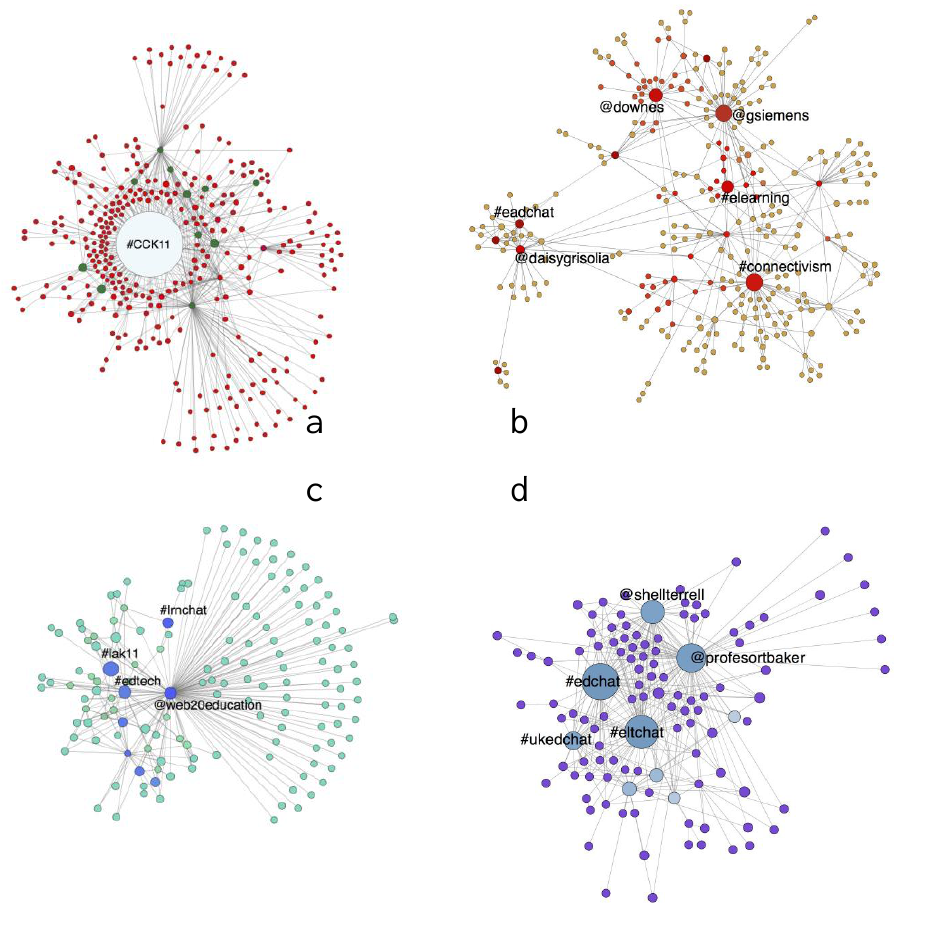
Figure 7. Structure for the four exemplary modular sub-networks. Sub-networks are manually separated from each other and the remaining sub-networks of strongly connected component, based on the outputs of modularity algorithm. Networks were manipulated for visualization. A comprises 26%; B =25%; C=12%, D= 9% of the entire course network; node size and distinctive colour size corresponds to the